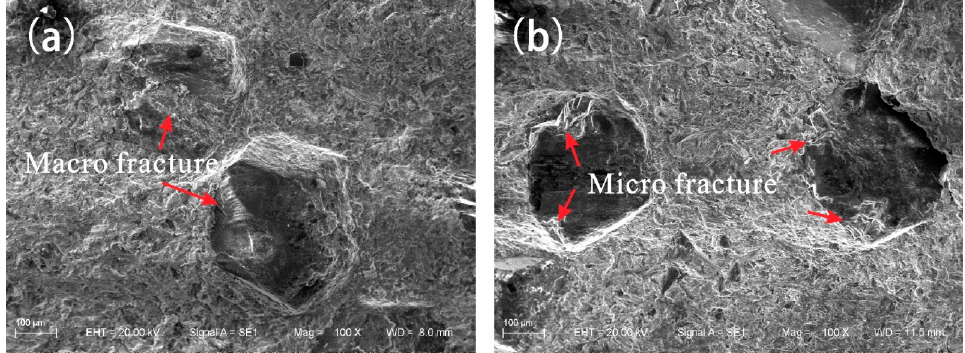
Figure 5. Friction morphology of diamond grits: ( a ) Friction morphology of sample F0; ( b ) Friction morphology of sample F4.